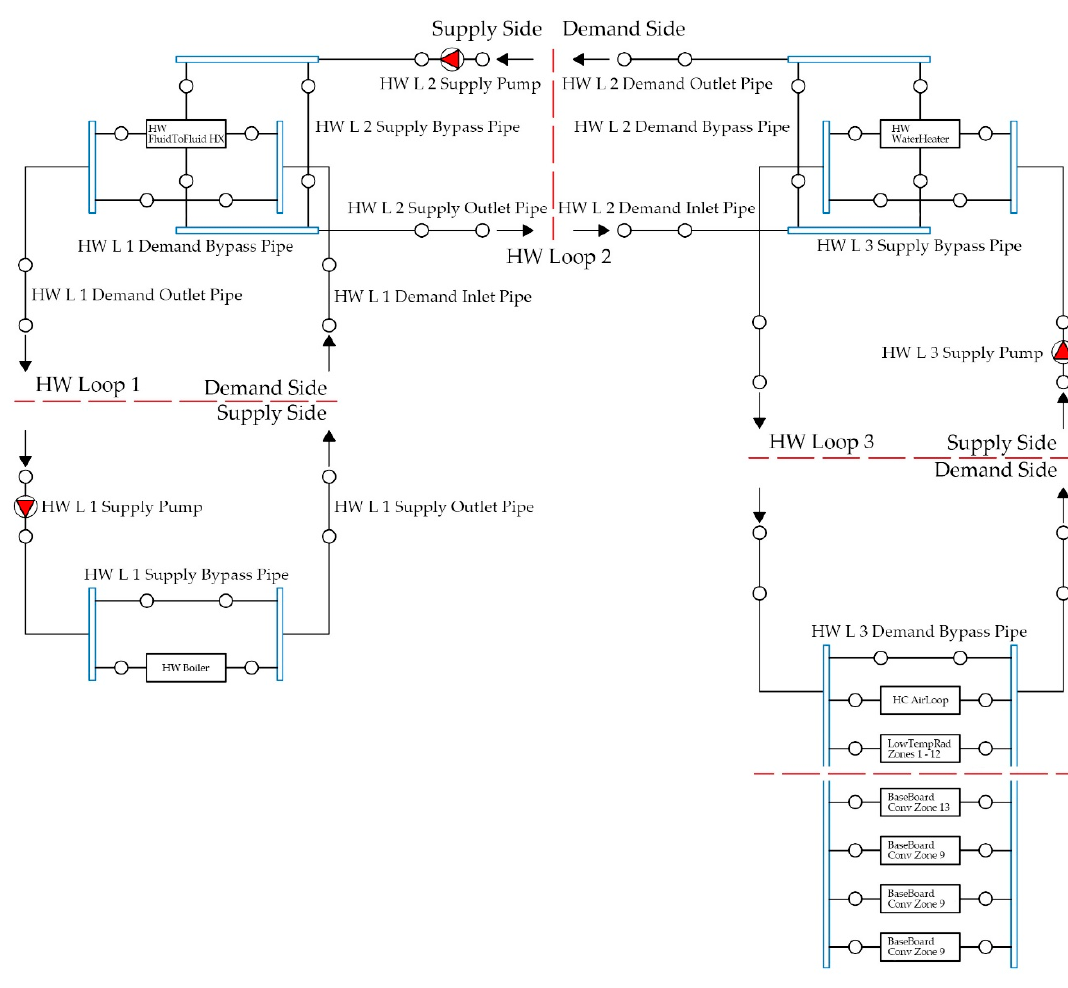
Figure 5. Hot Water Loops 1, 2, 3 and connections.